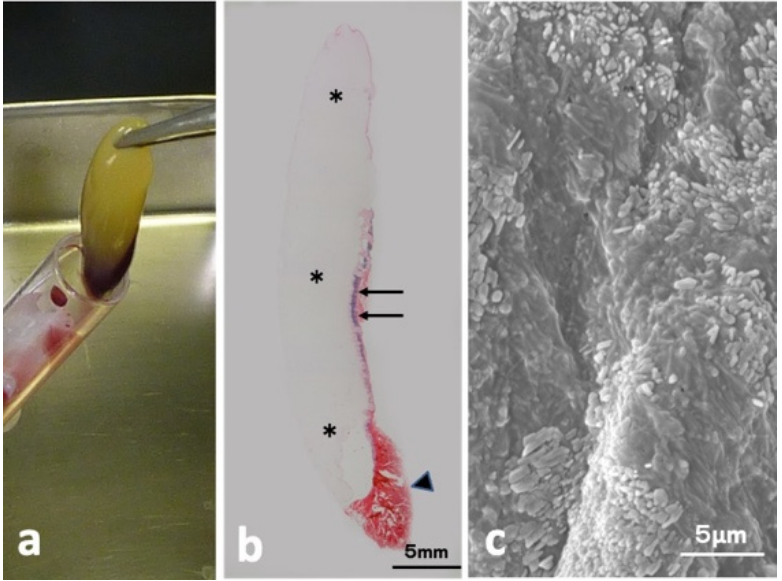
Figure 1. CGF glue. ( a ) Gross view of CGF, ( b ) HE-stained whole view showing week pinkish portion (*), violet (arrow), and red (arrowhead) (HE), ( c ) SEM showing oblong-shaped platelets on fibrin matrices.